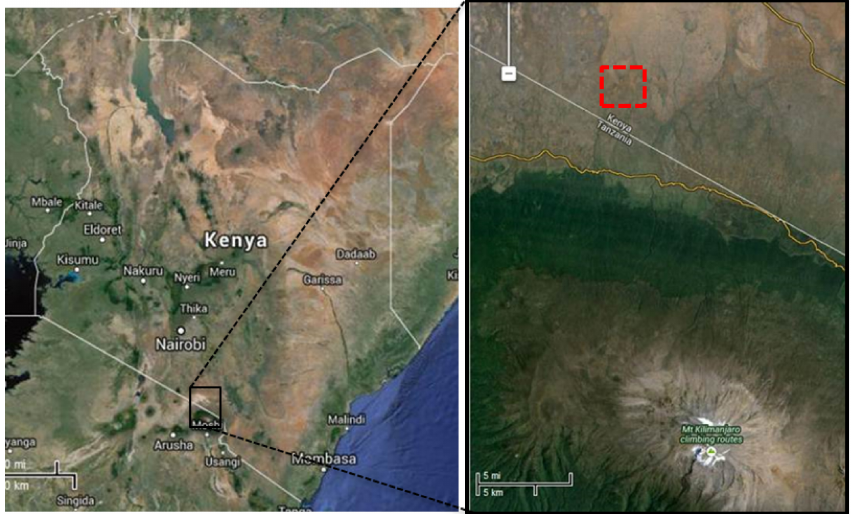
Figure 2. Location of studied contour trenching in Amboseli, Kenya (red dashed line). Source: Google Maps.